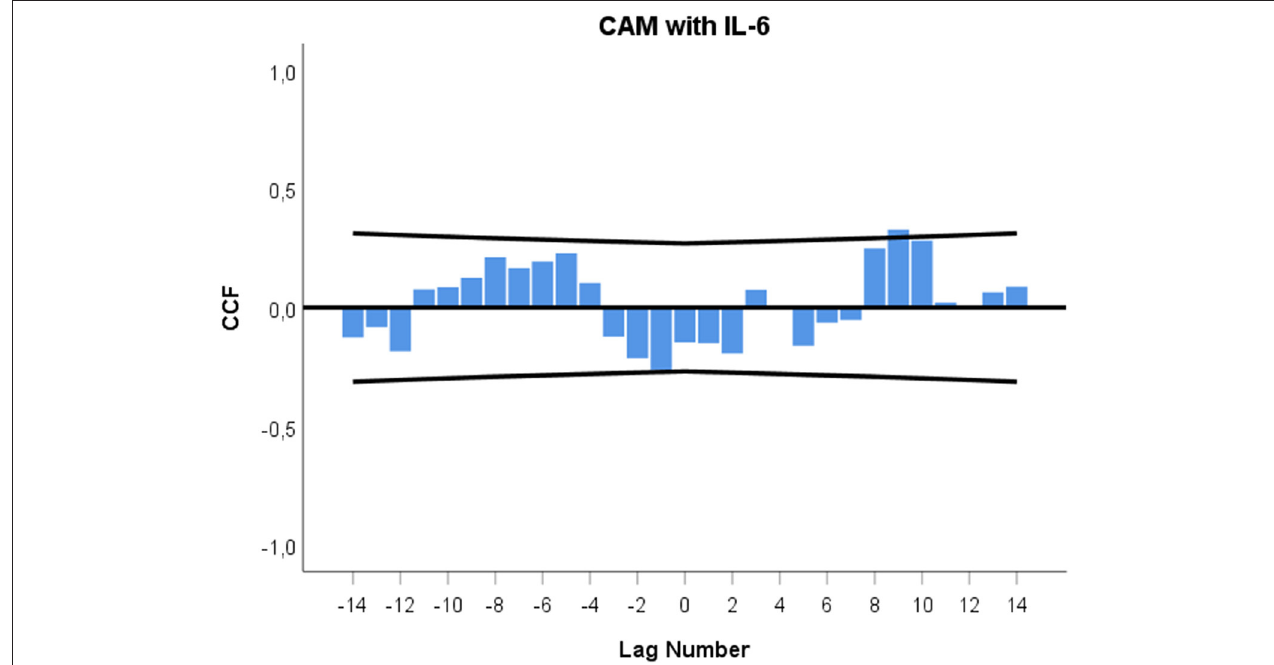
FIGURE 3 | Cross-correlation function (CCF) between CAM practice experienced as positive and urinary IL-6 concentrations. See description of Figures 2A–E for explanation of graph.